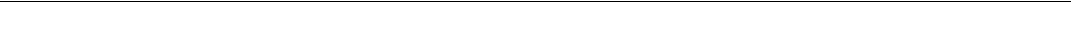
Table 5. Summary of Results According to Four Posed Hypotheses We Introduced During This Study Hypothesis